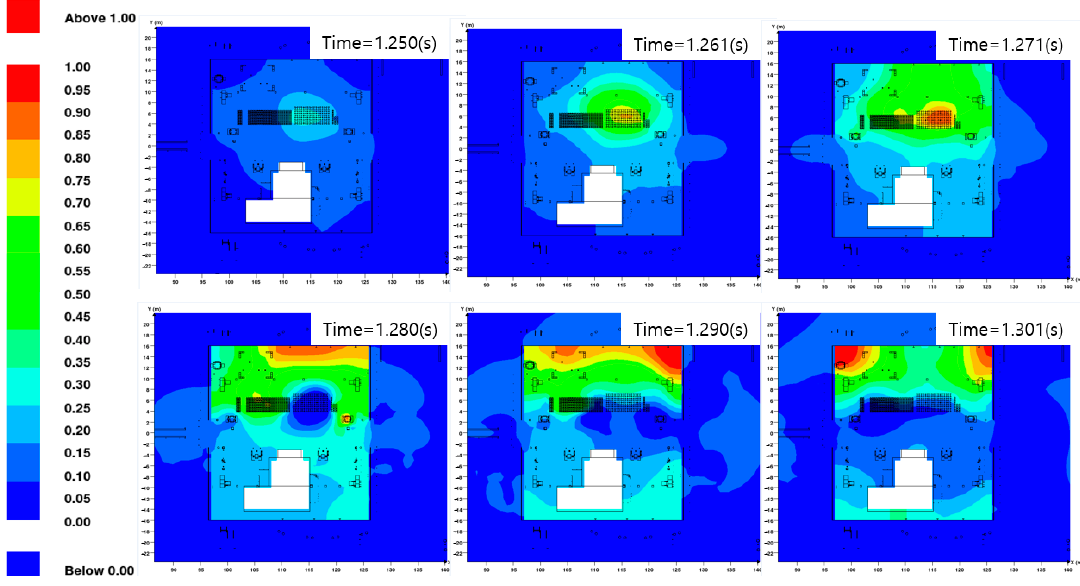
Figure 11. Explosion analysis result: time plot for blast pressure (maximum pressure 1.04 bar).